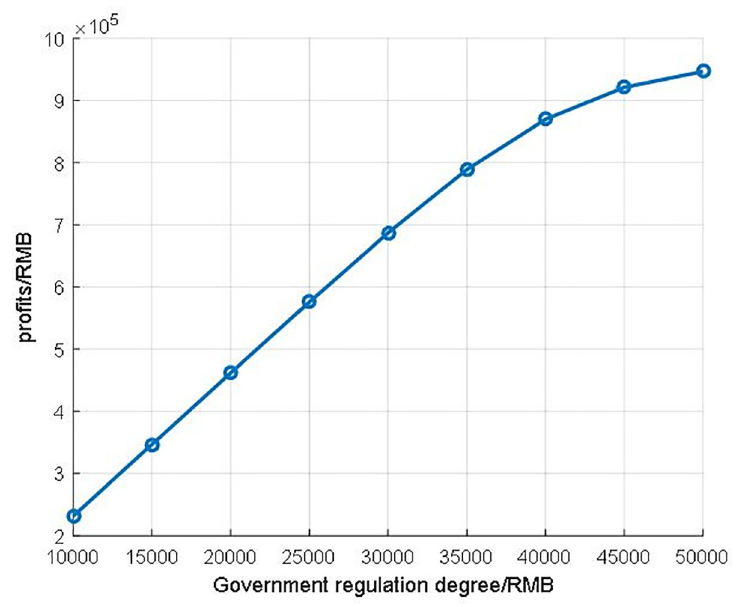
strictness of regulation, the total growth rate is down sharply. While the regulation gap raises from 45000 RMB to 50000RMB, the total growth rate of banks’ profit is only 2.784%. In other words, this blockchain-based system is quite sensitive to the regulation degree, especially in the lower interval. What should be noticed is that this blockchain is a consortium blockchain,